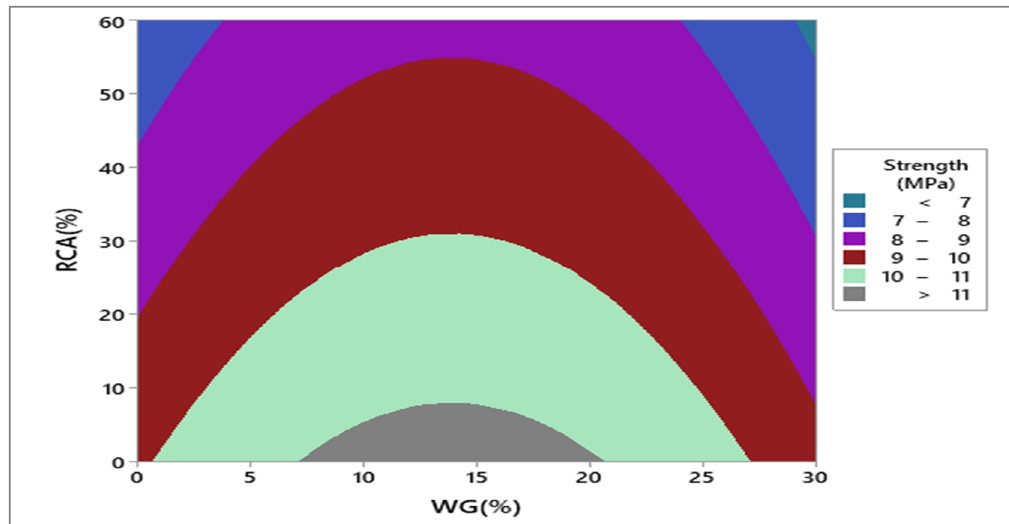
Figure 18. Three-dimensional response surface of punching strength.